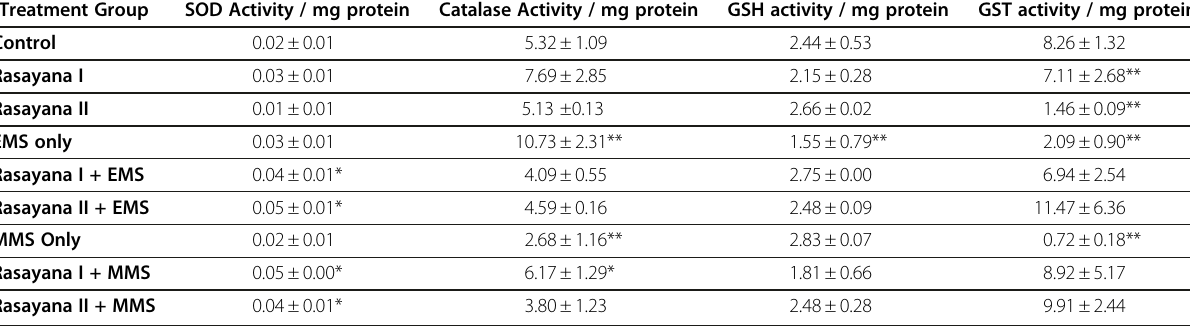
Table 3 Anti-oxidant levels in BR- and EMS- or MMS- treated animals Treatment